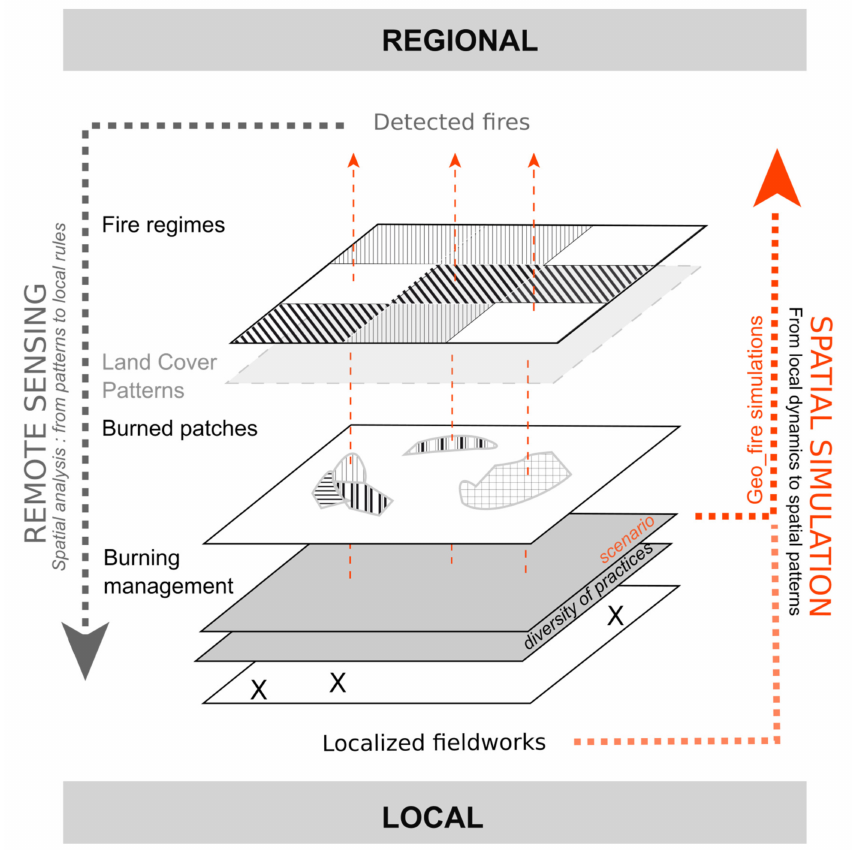
Figure 2. Di ff erent approaches to study fire regimes across